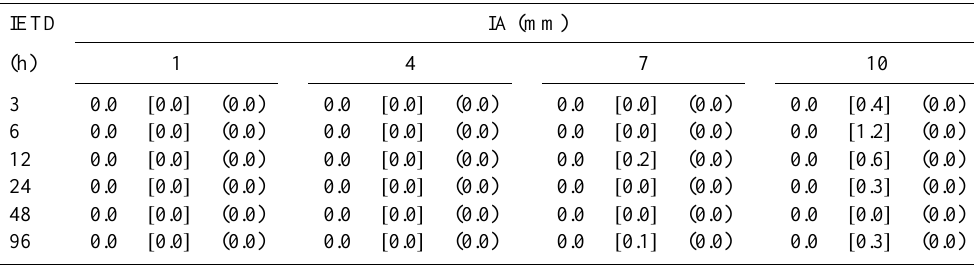
Table 3. p -values (%) obtained when testing the independence between the event volume and the wet weather duration for the rainfall series of Brescia, Parma [.], and Naples (.).